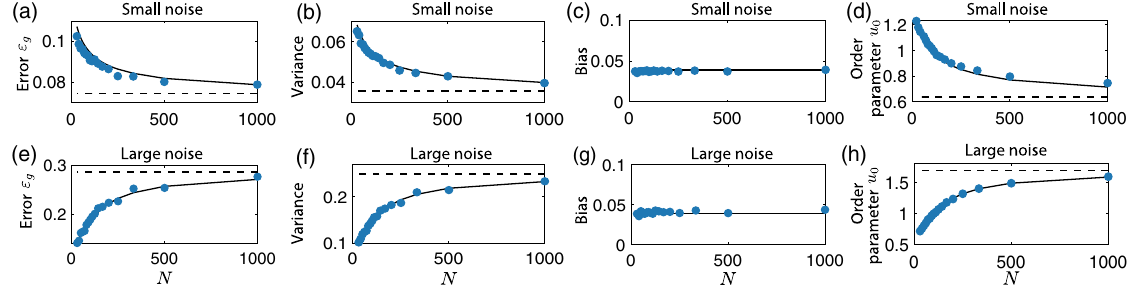
FIG. 12. Single hidden-layer ( L ¼ 1 ) ReLU network trained on MNIST binary classification of two digits (0 and 1) with details of the parameters in Appendix E. (a,e) Generalization error, (b,f) variance, (c,g) squared bias of the predictor, and (d,h) order parameter u 0 as a function of N . Black solid lines: theory. Blue dots: simulation. Black dashed lines: GP limit ( N → ∞ ). (a) – (d) Results in the small-noise regime where the generalization error decreases with N . (e) – (h) Results in the large-noise regime where the generalization error increases with N